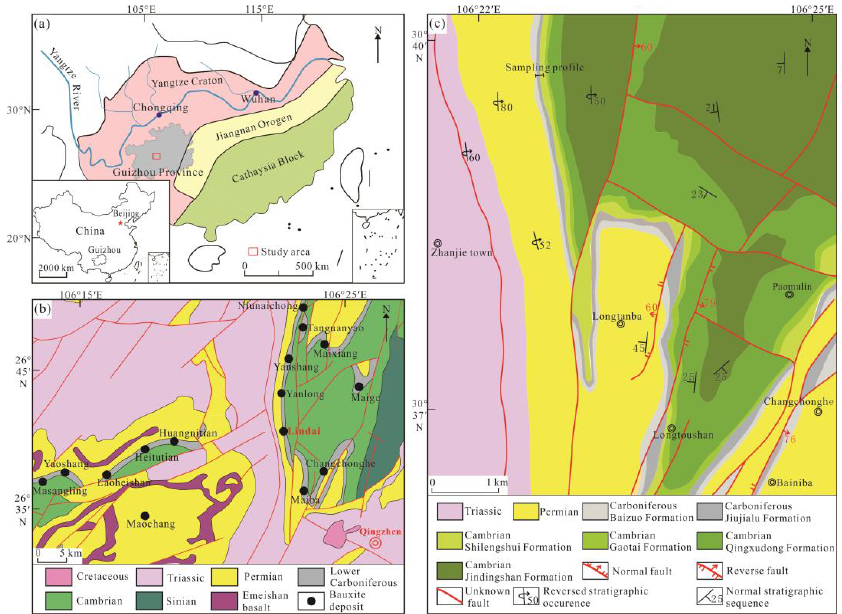
Figure 1. ( a ) Map of the South China Block showing the location of the study area in the Yangtze Craton. ( b ) Regional geological map of the Qingzhen bauxite ore field. ( c ) Geological map of the Lindai bauxite showing the sampling location.